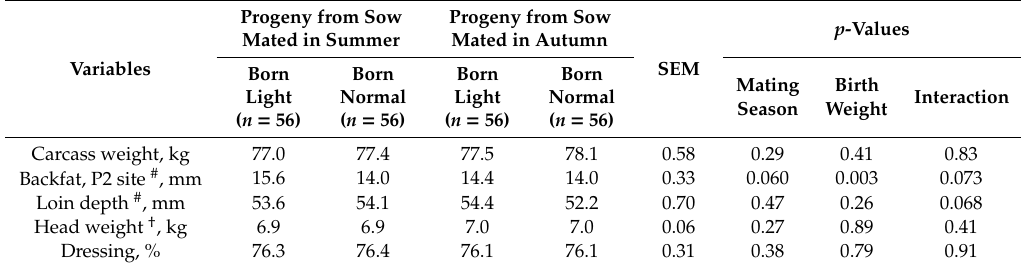
Table 5. Carcass traits (at 101 kg live weight) of focal progeny pigs born to sows mated in summer vs. autumn